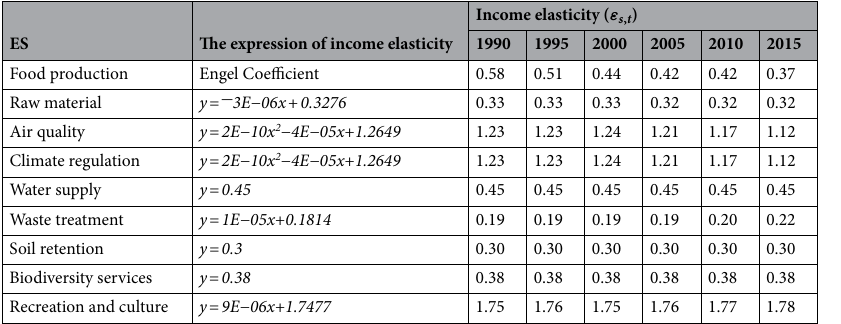
Table 5. Income elasticity of demand.